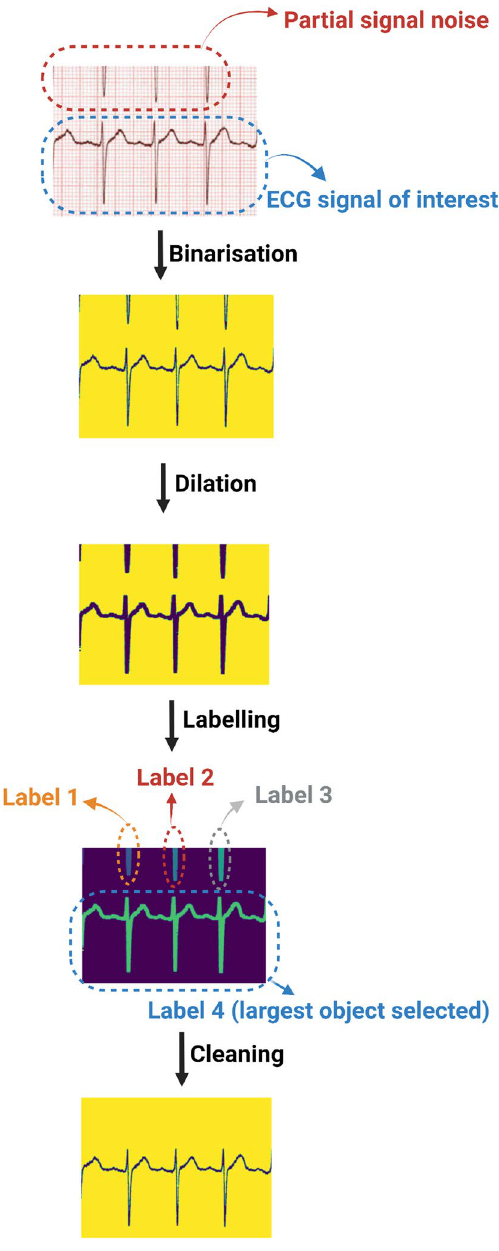
Figure 3. The cleaning process of a cropped ECG image. Following the cropping of the region of interest, a dilation process connects the possible breaking points horizontally to obtaining the full ECG signal. Thereafter, the labelling process identifies the largest object as the signal of interest. Finally, artefacts within the cropped image are removed to retain the signal of